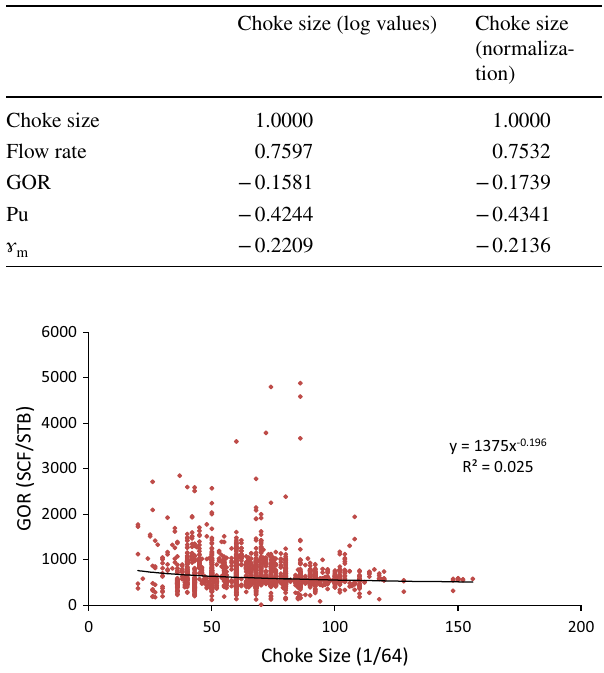
Table 3 Correlation between the log and typical values of the input and the output parameters